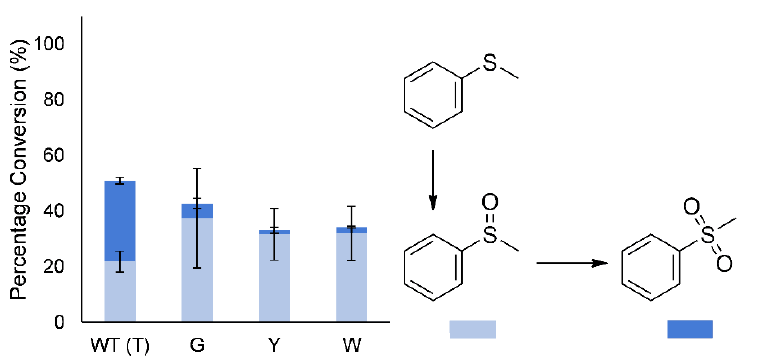
Figure 5. Effect of amino acid substitution at T513 on sulfoxidation of thioanisole by BVMO AFL210 . Product distributions are at conversion levels reported in Table S2.